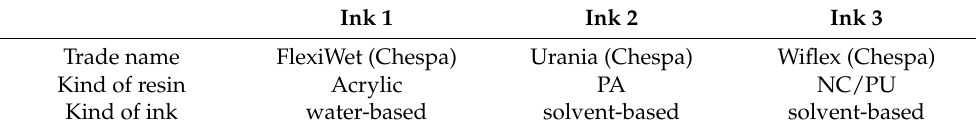
Table 2. The characteristics of the inks used in the